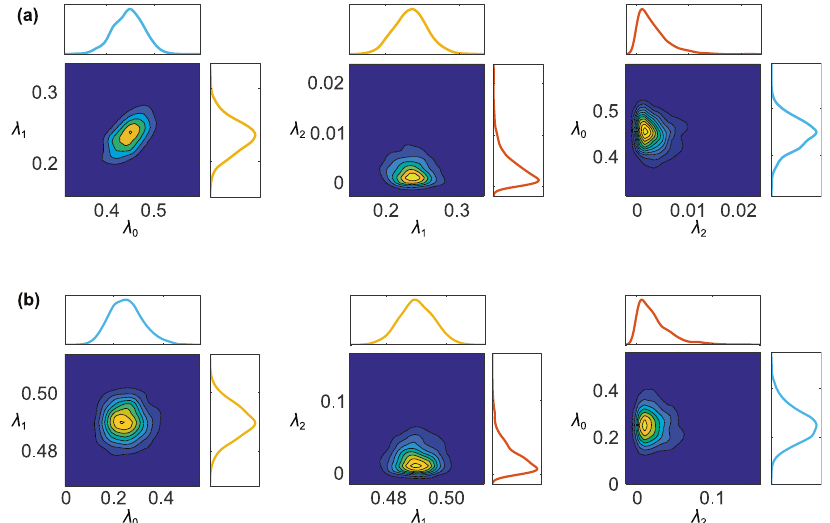
Fig. 9 Pairwise and single marginals for observables λ 0 , λ 1 , and λ 2 . a Points taken from the full likelihood, D = 256 example of Fig. 7a. b Points taken from pseudo-likelihood, D = 32 example of Fig.